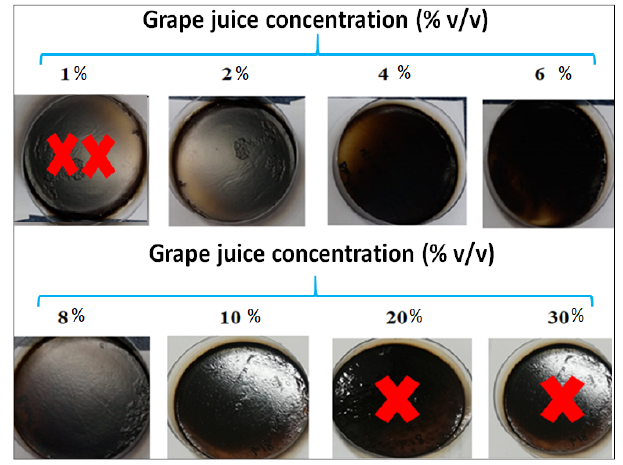
Figure 1. Images of NSDSC protein film containing different concentrations of grape juice (GJ), obtained at pH 12.0. Not-handleable—either brittle (XX) or sticky (X). Further experimental details are given in the text.